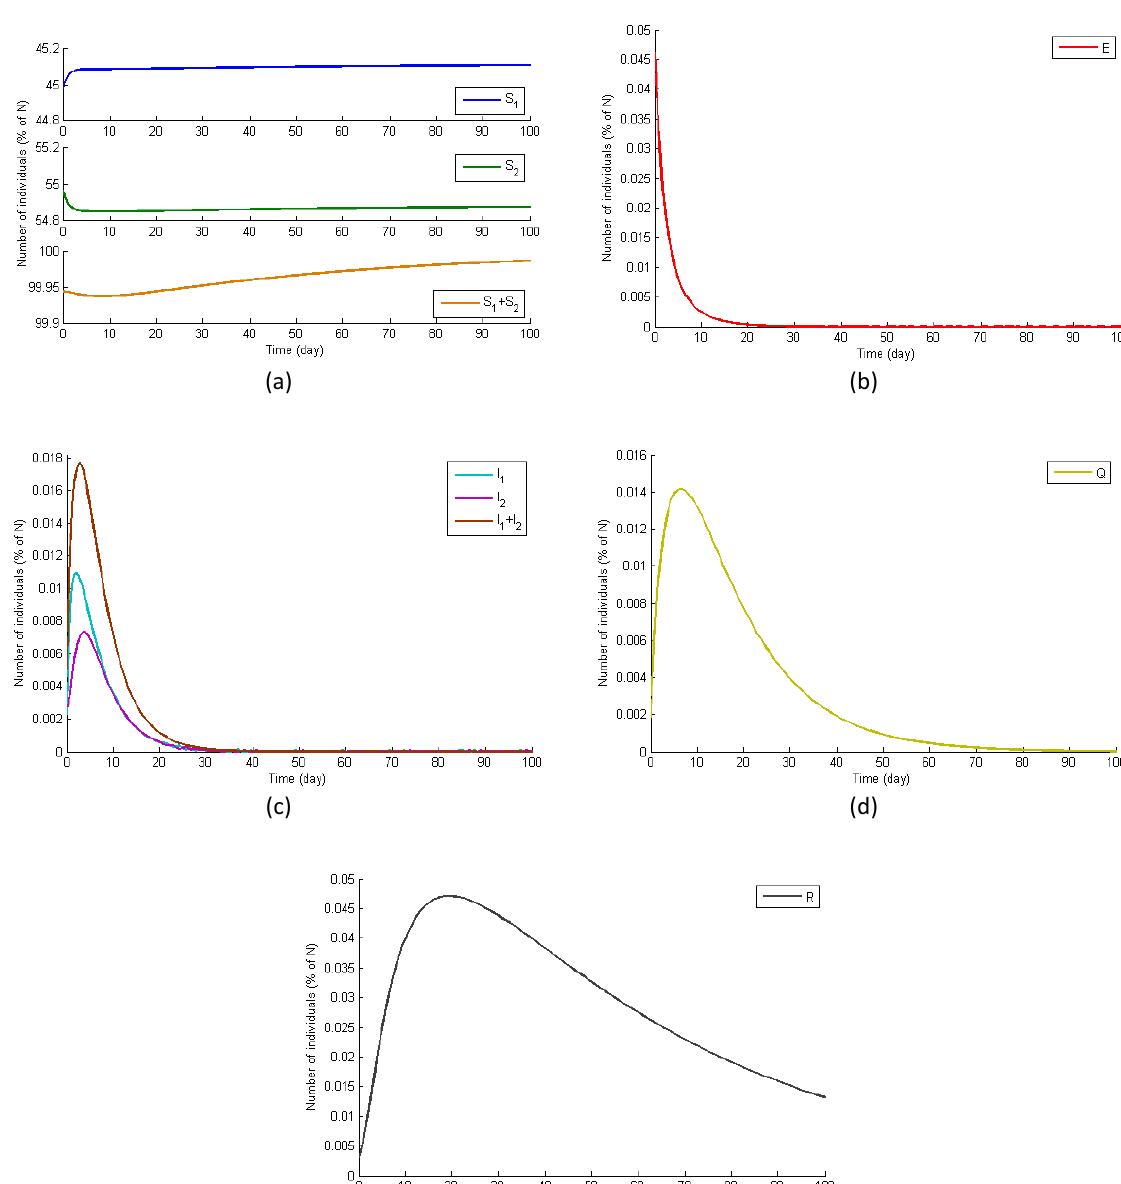
Fig. 3 : The subpopulation of the spread of COVID-19 with